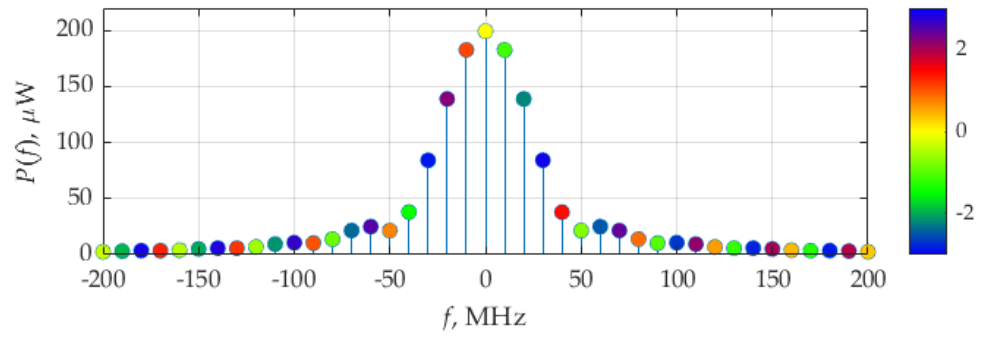
Figure 13. The spectrum of instantaneous power for the case of pulse train current.